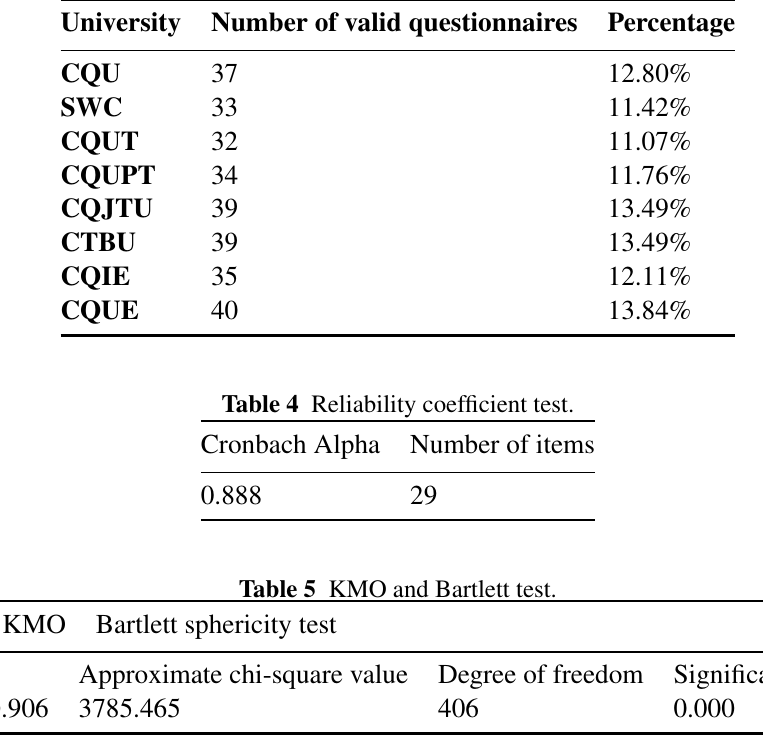
Table 3 Valid questionnaires in each university.